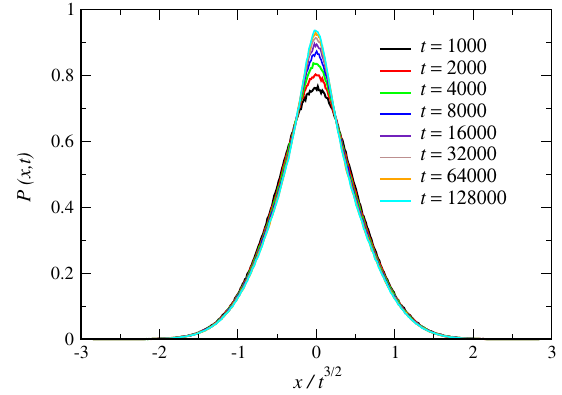
FIG. 13. P ð x; t Þ versus x=t 3 = 2 obtained from numerical simu- lation for D ¼ 20 = 3 . Increasing time, the solution converges to a scaling function. Such a x ∼ t 3 = 2 Richardson-Obukhov scaling is found for D > 1